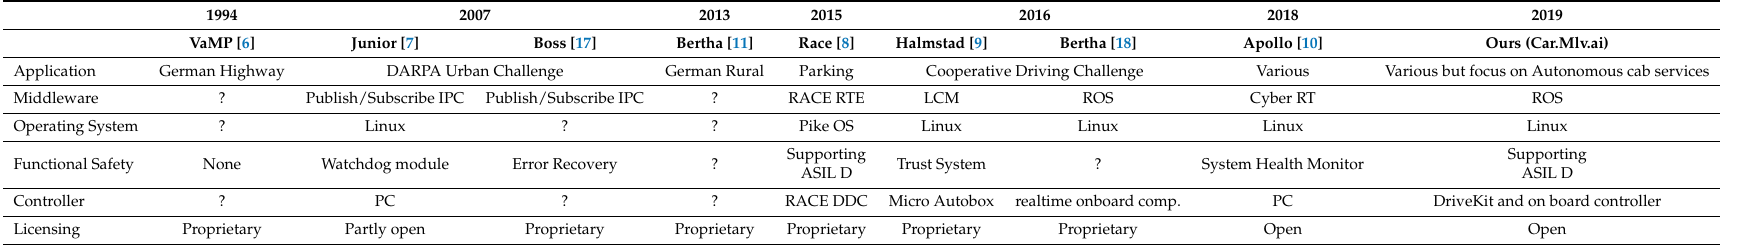
Table 9. Software comparison of relevant research based autonomous vehicles. ? illustrates that the required information is not